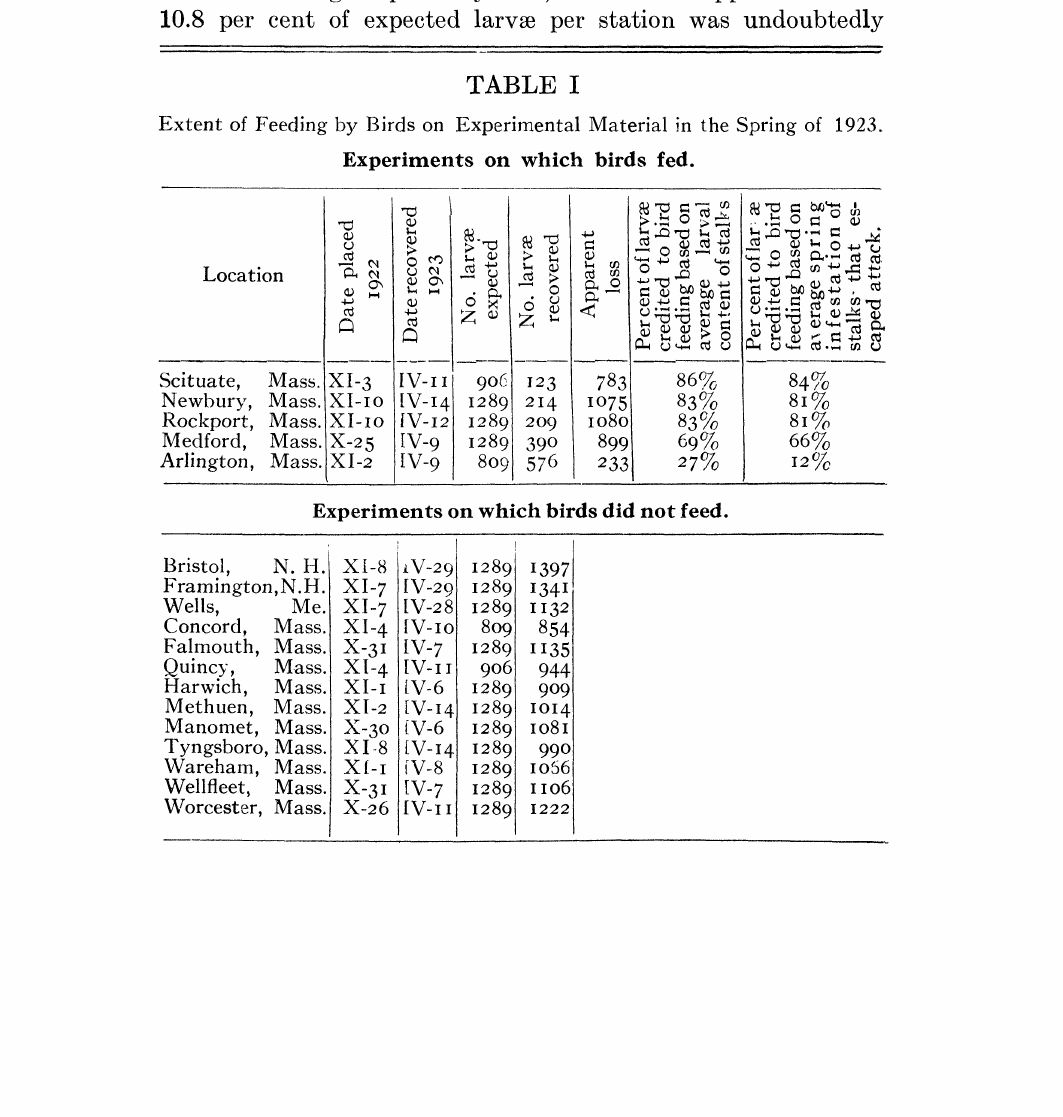
Extent of Feeding by Birds on Experimental Material in the Spring of 1923. Experiments on which birds